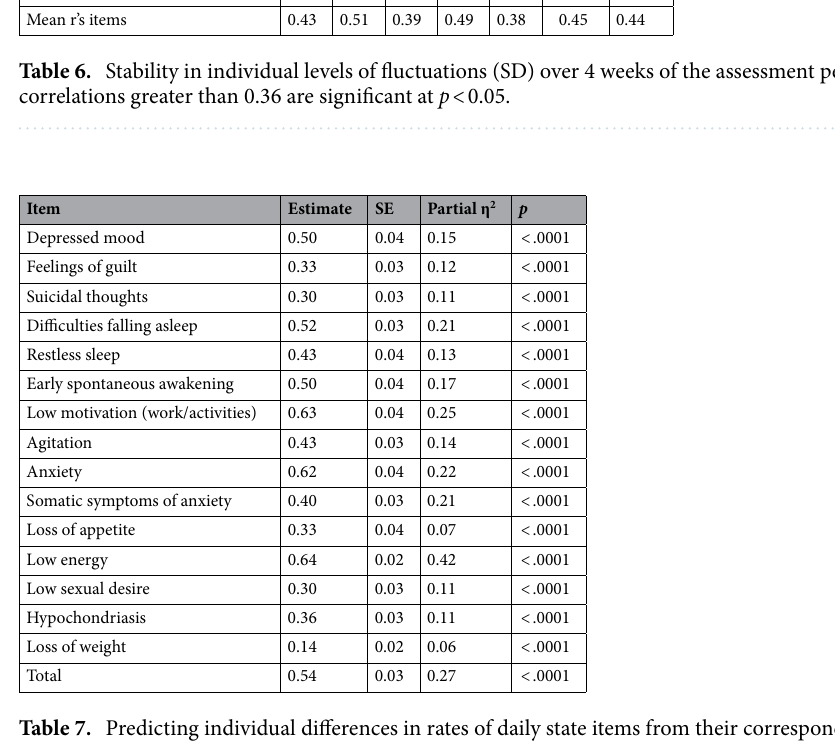
Table 7. Predicting individual differences in rates of daily state items from their corresponding baseline traits. Person-level N = 50; daily-level N = 952. All models were estimated controlling for gender and age. partial η 2 : represent an estimate of how much variance in the state item is accounted for by the trait item. According to Cohen (1988) 0.01 partial η 2 effect considered as small, 0.06 considered as medium and 0.14 considered as